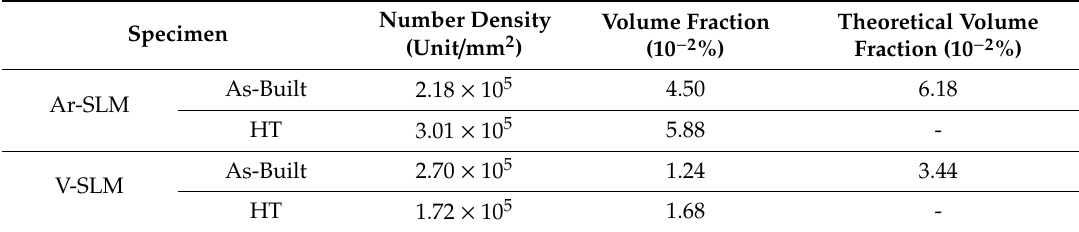
Figure 6. BSE (backscatter detector) images of HT specimens: ( a ) Ar-SLM, and ( b ) V-SLM specimens. Table 7. Number density and volume fraction of oxides in SLM-fabricated specimens.